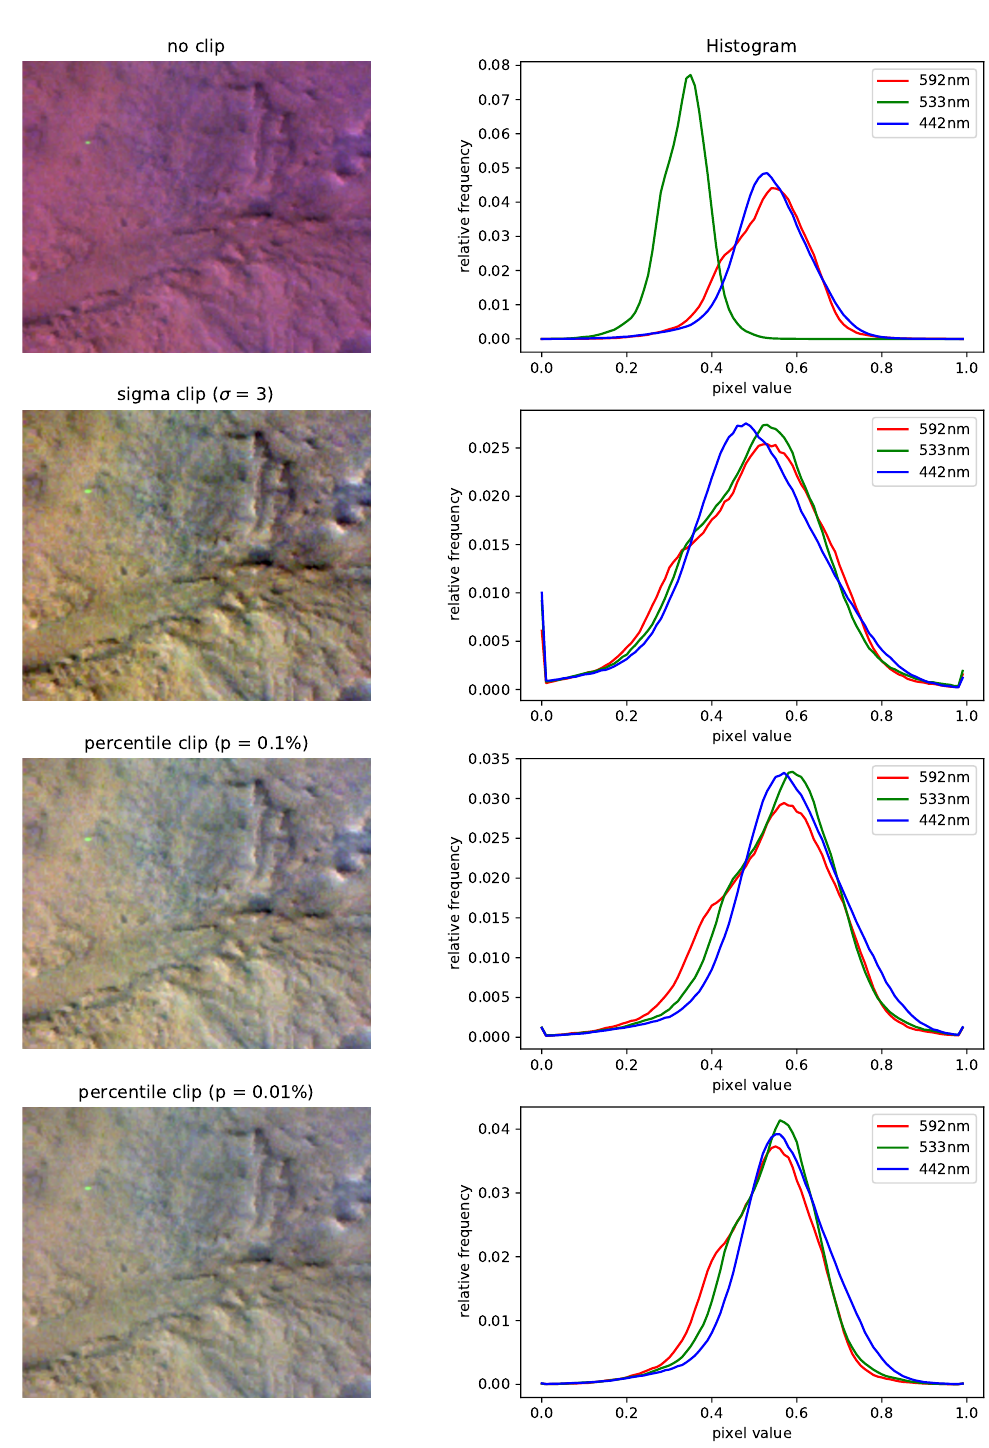
Figure A2. Comparison of different clipping methods and their impact on appearance and distribu- tion of pixel values on CRISM observation